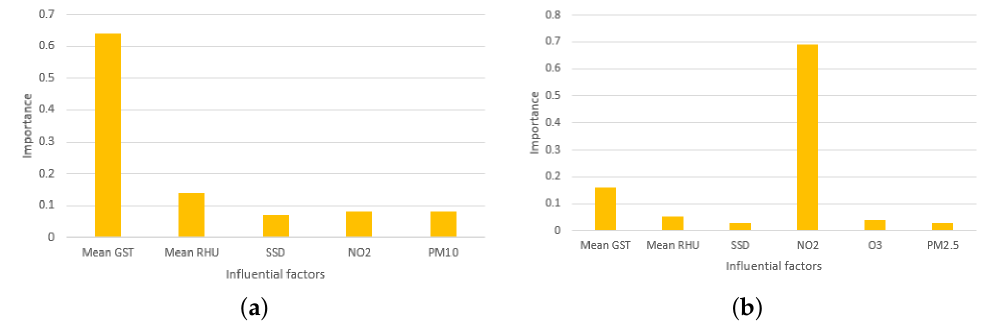
Figure 14. The importance of predictor variables of RFR for ( a ) O 3 and ( b ) SO 2 at Ma Lian Kou.